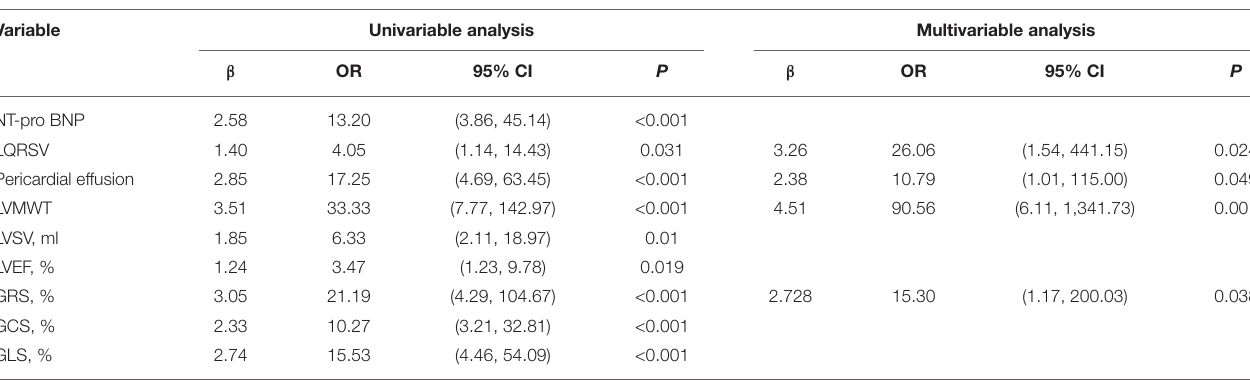
TABLE 3 | Logistic analysis result for independent predictors of AL CA.